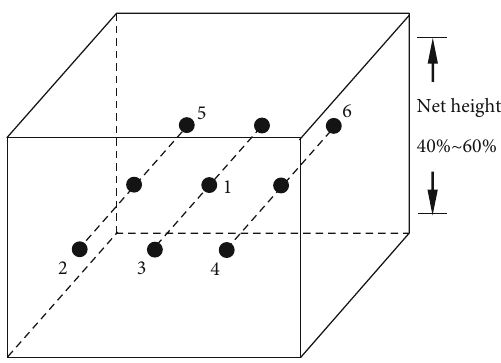
Figure 7: Sketch map of the indoor temperature measurement